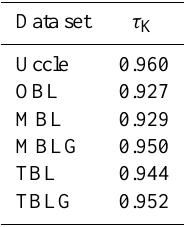
Table 9. RMSE of different fitted